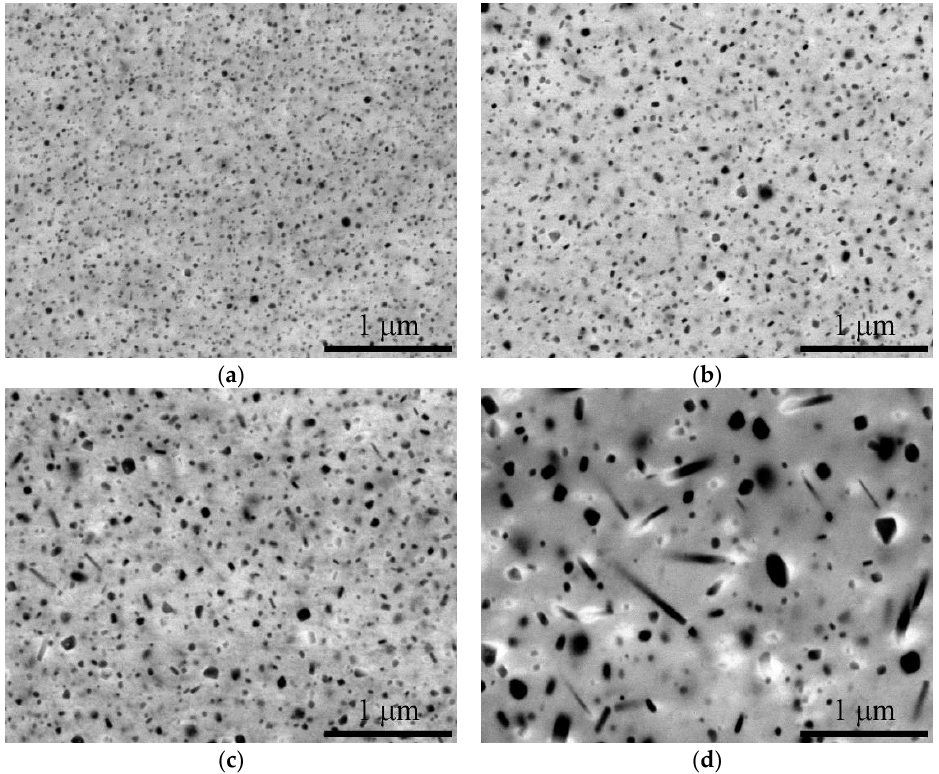
Figure 7. SEM micrographs of oxides dispersed in grain interiors after annealing at 1200 ◦ C for ( a ) 1 h, ( b ) 4 h, ( c ) 8 h, ( d ) 48 h in the Fe-11Al-1O